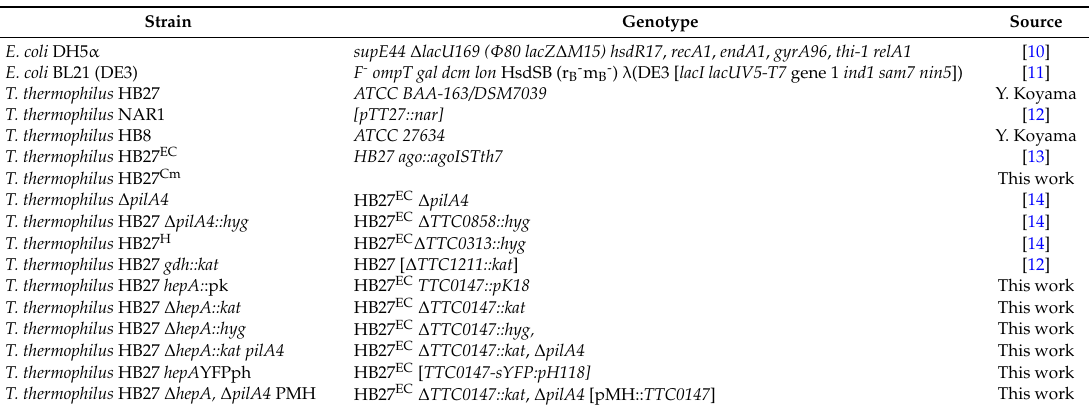
Table 1. Strains used in this